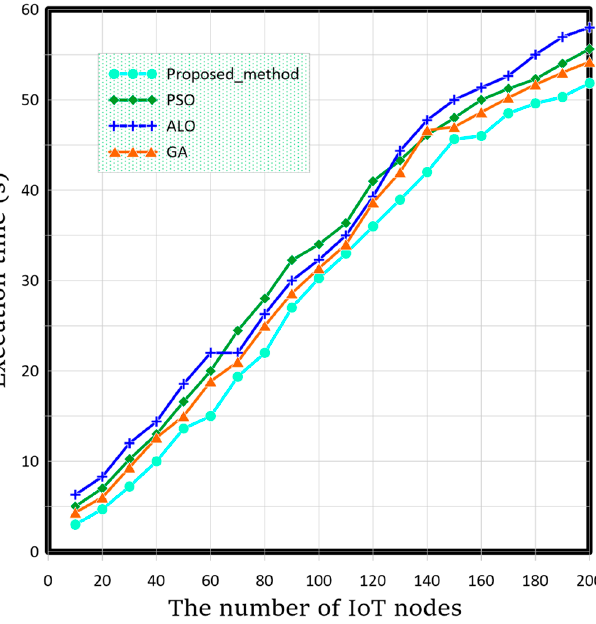
Figure 7. Comparison of the execution time among the proposed method, PSO, ALO, and GA algo- rithms.